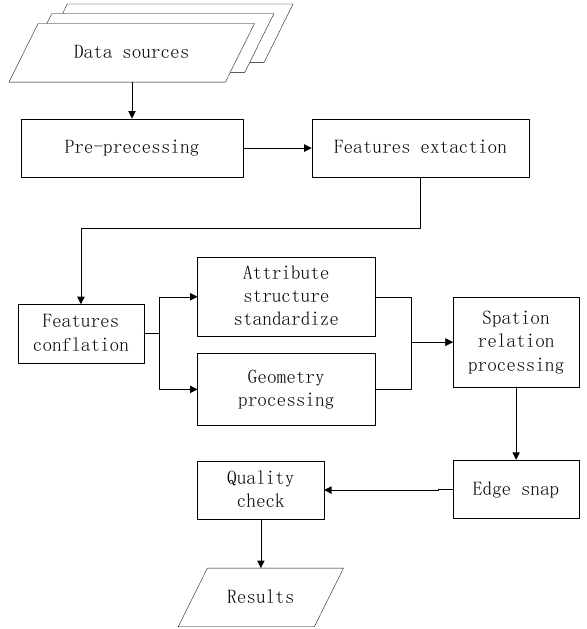
Figure 2 General Data Integration